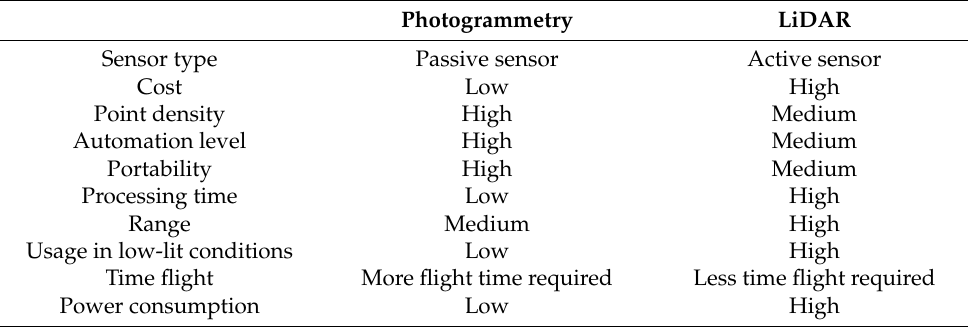
Table 2. Comparison of photogrammetry and